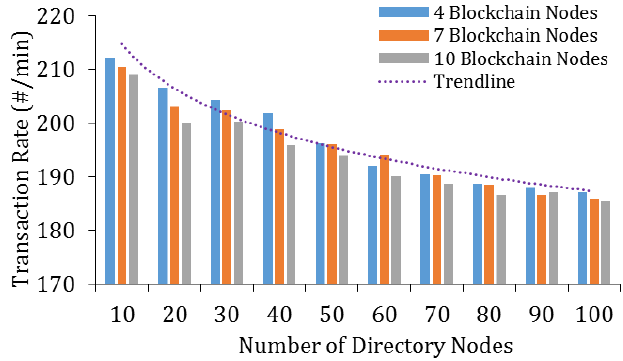
Figure 12. Transaction rates with a different number of blockchain nodes and directory nodes.